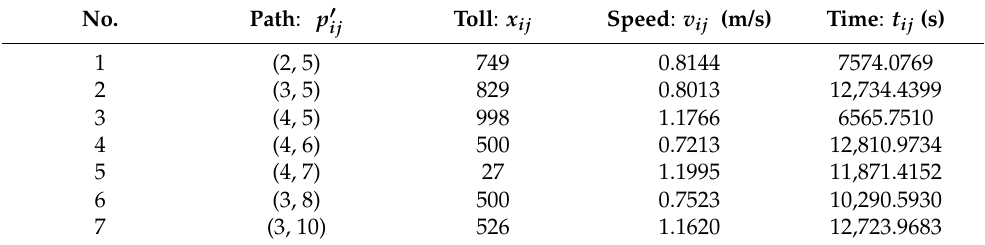
Table 4. Algorithm 1 calculation results.